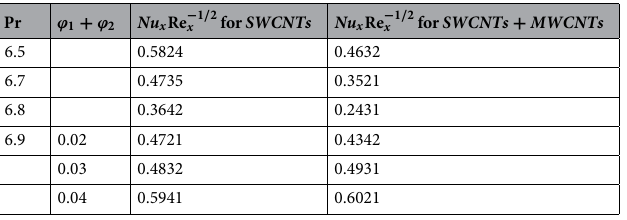
Table 4. Impact upon Nusselt number regarding different values of emerging parameters.